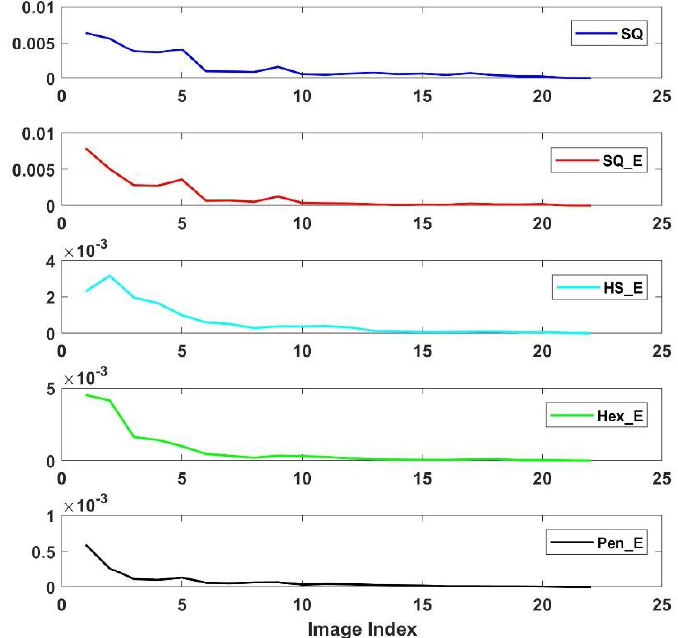
Figure 11. MSE results between each two candidates of certain ANCHOR. Each of the candidates are computed as average values of orientation of the gradient for certain number ( n ) of images.